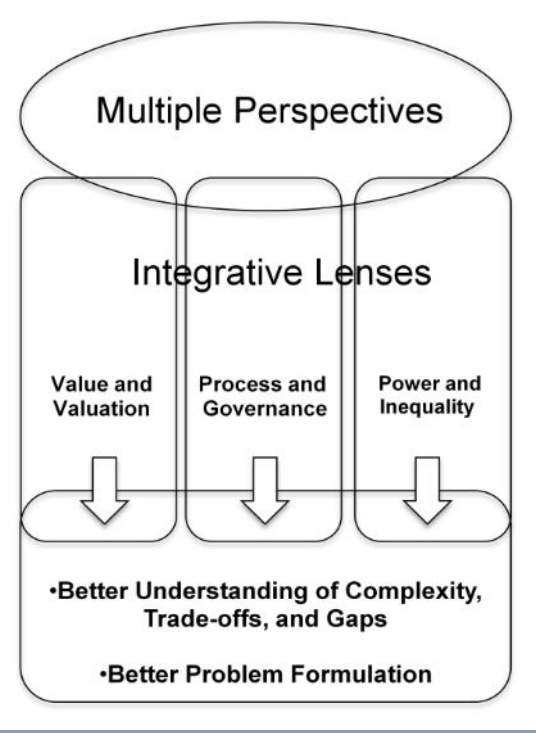
Fig. 1 . The Advancing Conservation in a Social Context (ACSC) Integrative Framework. Source Hirsch et al.